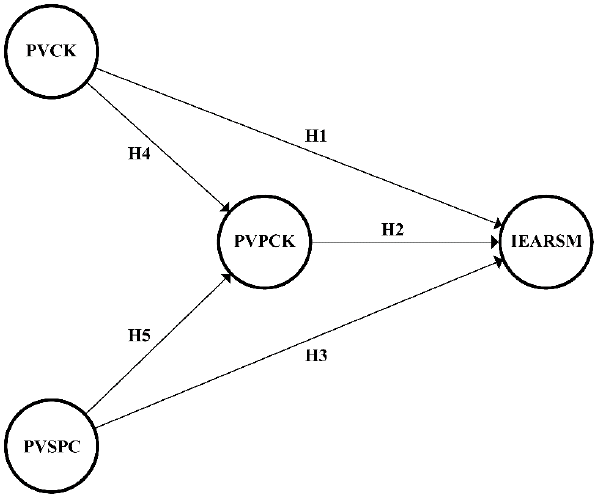
Figure 1. A proposed structural model with constructs. PVCK = perceived value of content knowledge, PVPCK = perceived value of pedagogical content knowledge, PVSPC = perceived value of students’ participation in the classroom, IEARSM = intentions toward engagement with academic reading on social media.